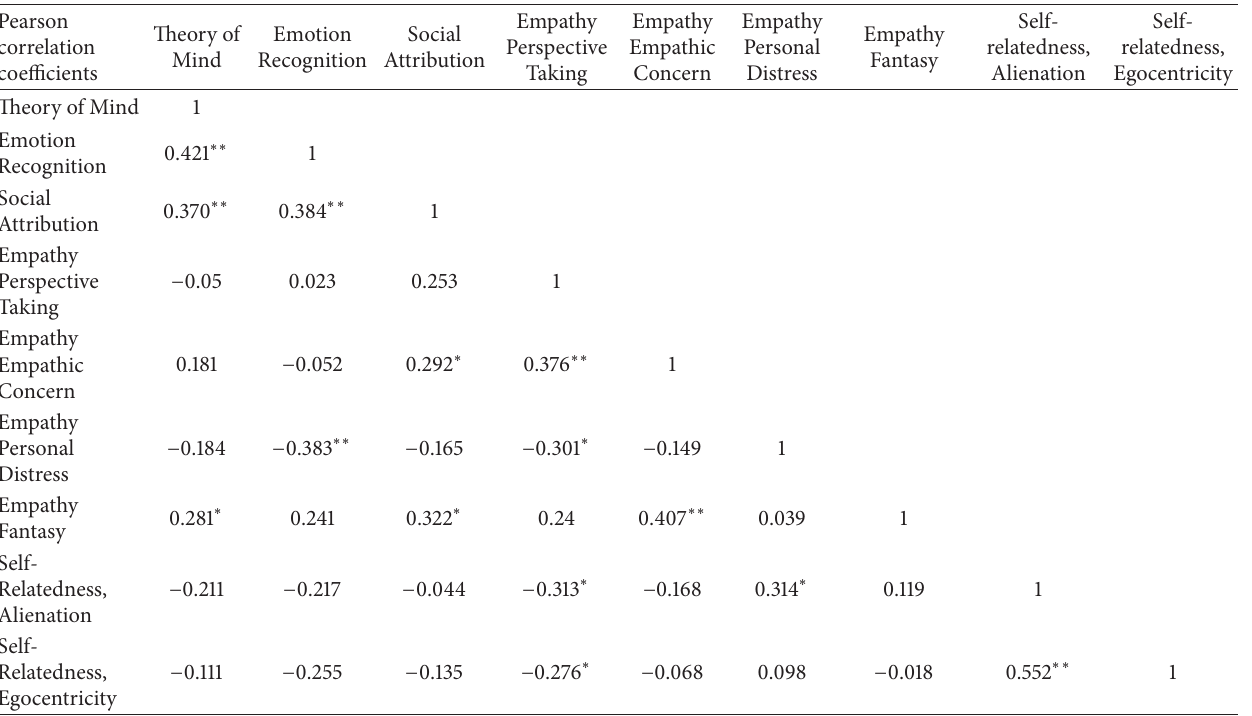
Table 3: Correlations among the social cognitive measures in both groups.